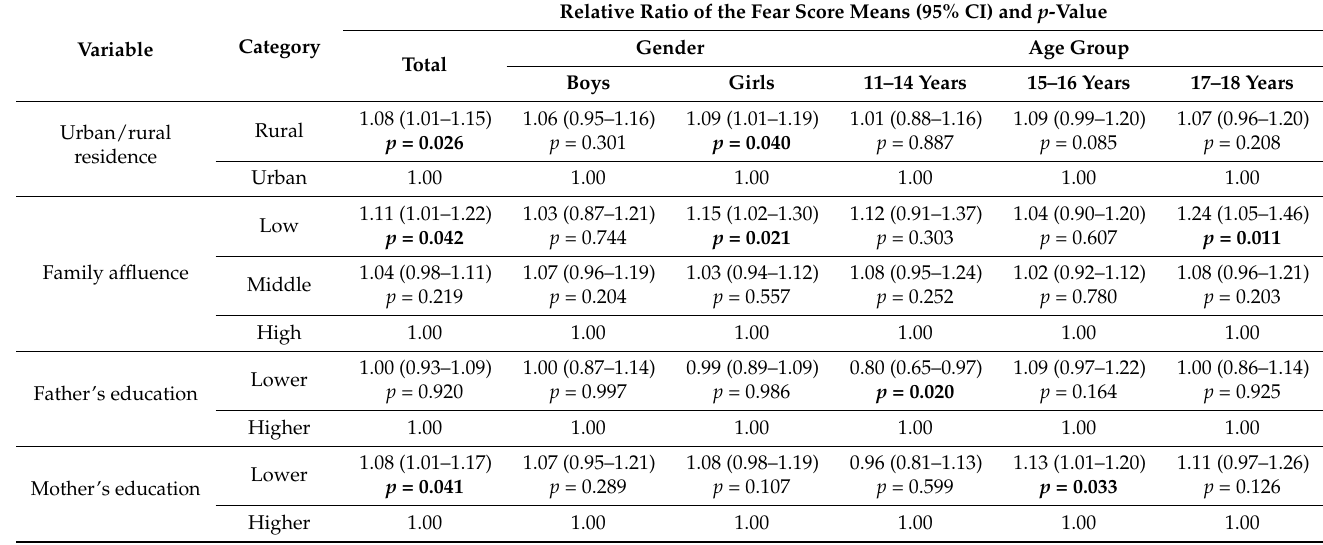
Table 6. Association of child and adolescent dental fear with several social